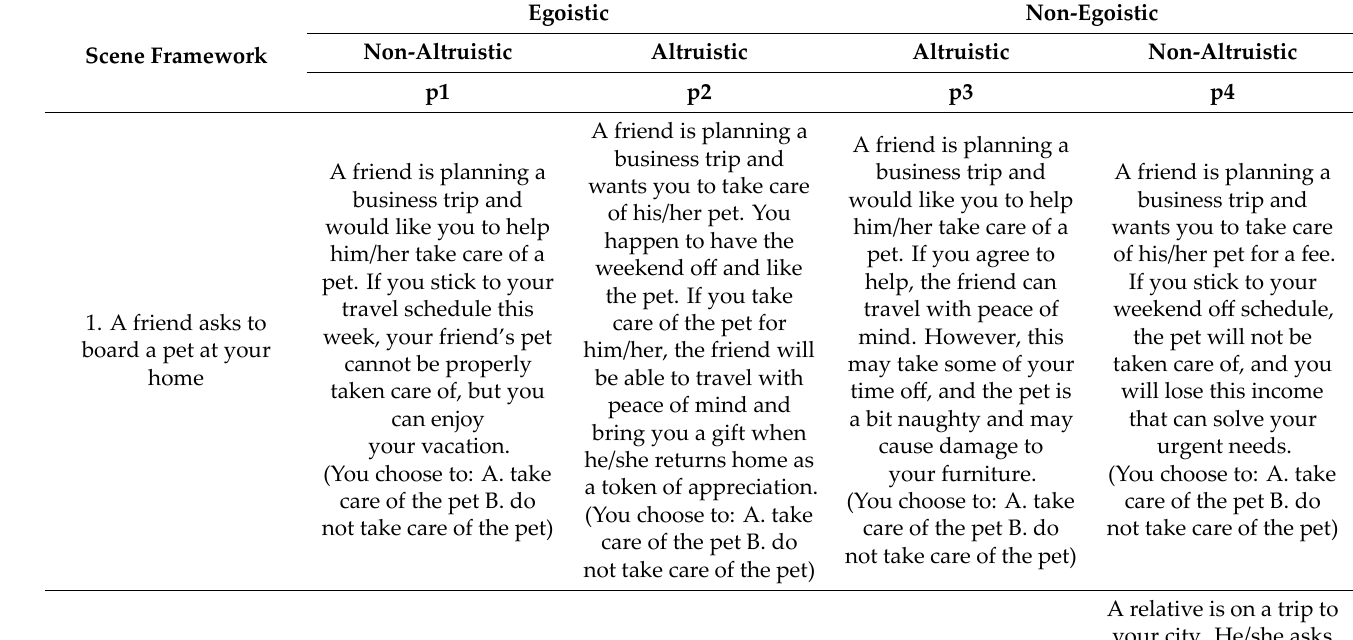
Table A1. The Six Frameworks with a Total of 24 Scenarios Retained in Study 1 (in